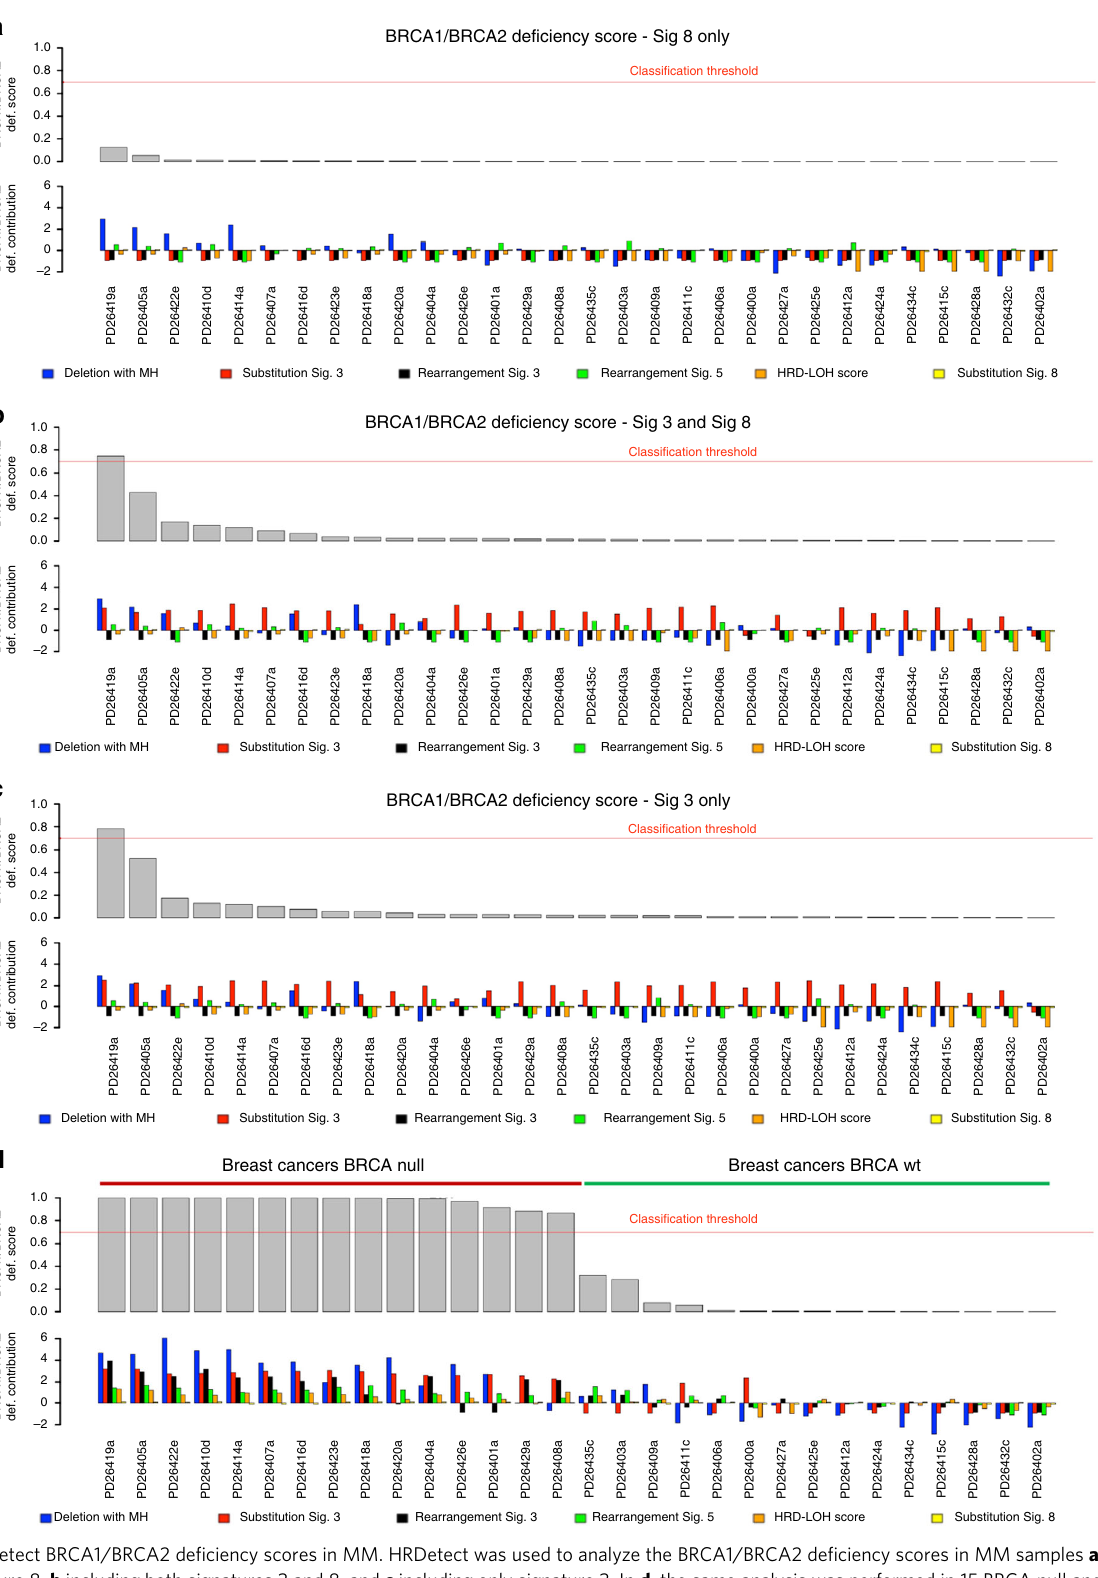
Fig. 2 HRDetect BRCA1/BRCA2 de fi ciency scores in MM. HRDetect was used to analyze the BRCA1/BRCA2 de fi ciency scores in MM samples a including only signature 8, b including both signatures 3 and 8, and c including only signature 3. In d , the same analysis was performed in 15 BRCA null and 15 BRCA wt breast cancers 18 . Scores are ordered from highest to lowest and a classi fi cation threshold of 0.7 is used to classify samples as HRD-positive (see Davies et al. 18 ). Below each score, the contribution of the six features that are used by HRDetect is shown. Each contribution is given by the amount of a feature in a sample, log-transformed and standardized according to mean and standard deviation of the features in Davies et al. 18 and fi nally multiplied by the corresponding HRDetect logistic regression coef fi cient. Thus, a positive contribution indicates a feature value higher than the average of the HRDetect original training set, and feature contributions are directly comparable. Sig. =